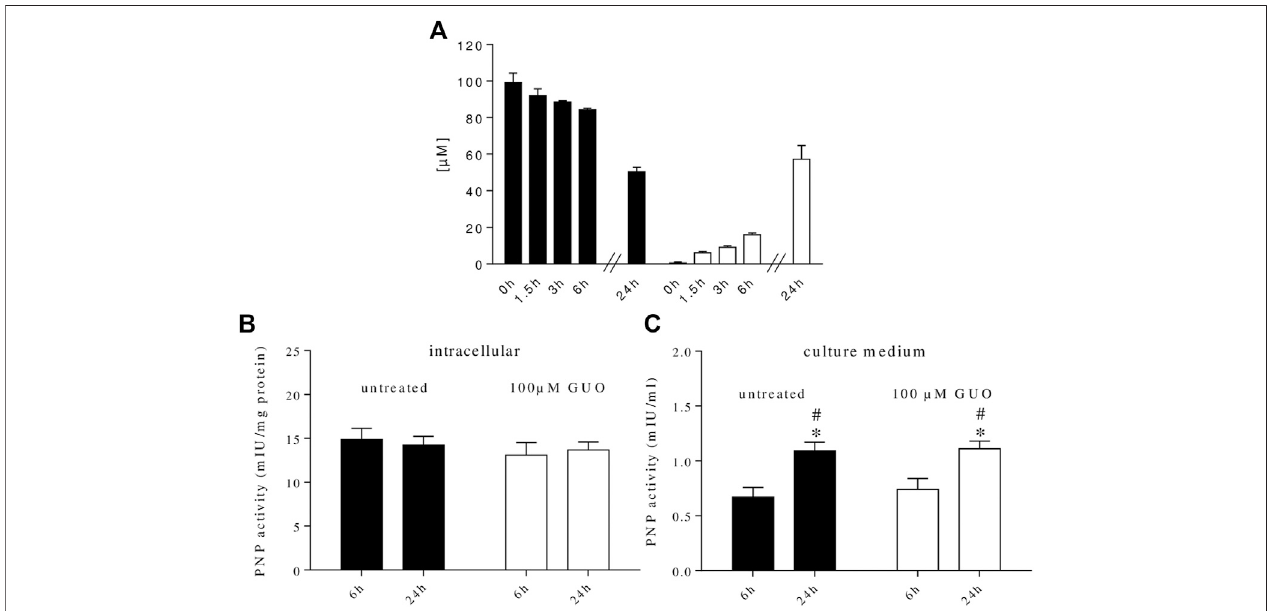
FIGURE4| Metabolicfateofextracellularguanosineandpurinenucleosidephosphorylase(PNP)activityinSH-SY5Ycellcultures. (A) GUO(100 µM)wasaddedto theculture medium containing0%serum.Attheindicatedtimes,analiquotofthemedium wastakenandanalyzed byHPLCasdescribed inmaterialsandmethods. (B) PNP activity was measured within SH-SY5Y neuroblastomacells or (C) in the culture medium. For thispurpose, SH-SY5Y cells were incubated in a serum-free medium supplementedornotwith100 µMGUO.After6and24 h,analiquotofthemedium wastakenandtheenzymepresentwasconcentratedusingAmiconUltra fi lters while cells were scraped in lysis buffer and cytosolic extracts were prepared. PNP activity was assayed using 100 μ M GUO as substrate plus 50 mM Pi as co-substrate for 15 minat 37 ° C.Theconcentrationofthenewly formed product, GUA, wasmeasured byHPLC analysis.PNP activity wasexpressed asmilli-International Units(mIU) per mg protein or ml of culture medium. Values are the mean ± SEM of at least fi ve independent experiments, each run in duplicate. Statistical analysis was performed using atwo-way ANOVA followedbyTurkey ’ smultiple comparison test, * p < 0.05comparedwithuntreatedcellsat 6 hand # p < 0.05 compared withGUOtreated cells at 6